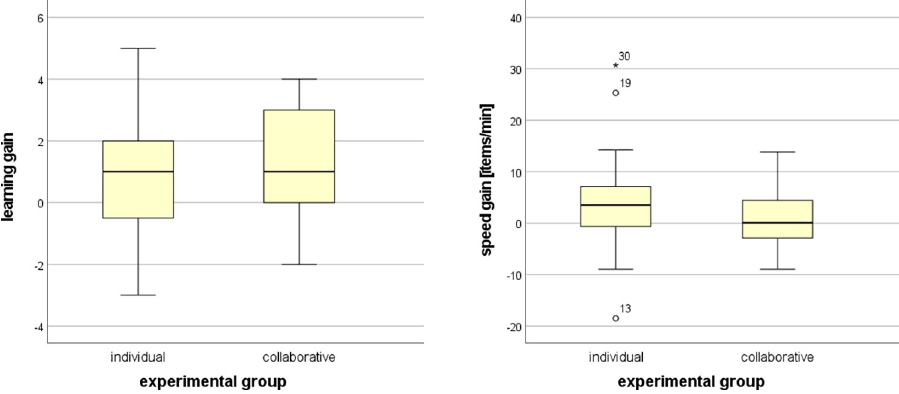
Fig 7. Comparison of learning gain and speed gain between experimental